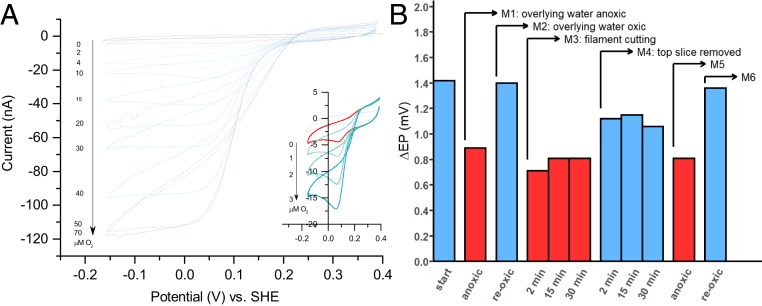
Oxygen reduction capability of cable bacteria and its dependence on redox zonation. (A) Cyclic voltammograms of intact cable bacteria deposited on a gold disk electrode (PBS at pH 7.4; scan rate, 0.02 Vs−1) at different concentrations of O2 (µM) in solution. (Inset) Cyclic voltammograms at low O2 concentrations. (B) Response of long-distance electron transport to a sequence of manipulations, as measured by the difference in EP (ΔEP) at the sediment-water interface and at 30 mm depth (the corresponding vertical profiles are show in SI Appendix, Fig. S5). Start, sediment with active long-distance electron transport by cable bacteria (high ΔEP); M1, anoxic overlying water (residual ΔEP due to diffusive electric potentials); M2, oxic overlying water; M3, sediment core was cut at a depth of 5 mm with a thin wire (3 mm below the oxic zone), but the sediment slice was left in place while the overlying water was oxic; M4, the top sediment slice was removed, so cells within the suboxic zone had instantly access to O2; M5, overlying water was made anoxic after 60 min (to verify that the response after M4 was due to cable bacteria); M6, oxic overlying water (to verify that the long-distance electron transport was reestablished).